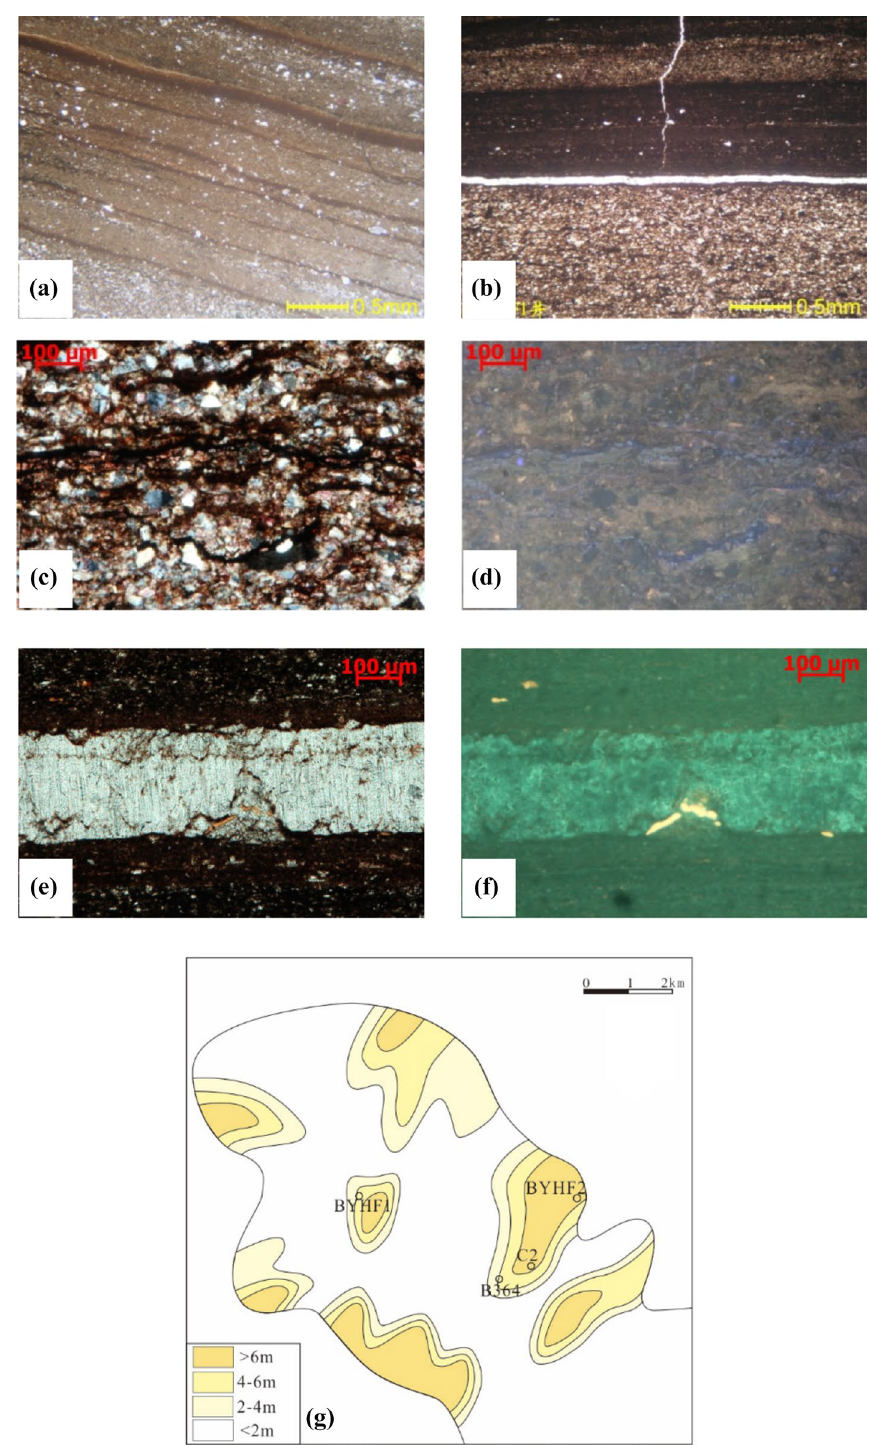
Fig. 7 a Silt laminae is inter- bedded with clay laminae from well Cheng 2, 2821.57 m; b par- allel fracture occurs along the adjacent area of the two types of laminae from well BYHF 1, 2446.5 m; c, d hydrocarbon occurs in interparticle pores from well BYHF 1, 2427.55 m, with cross-polarized light and fluorescence, after Zhang (2014); e, f hydrocarbon occurs in calcite dissolution pores from well Cheng 2, 2800.32 m, with cross-polarized light and fluo- rescence, after Zhang (2014); g interlayer thickness of ORI